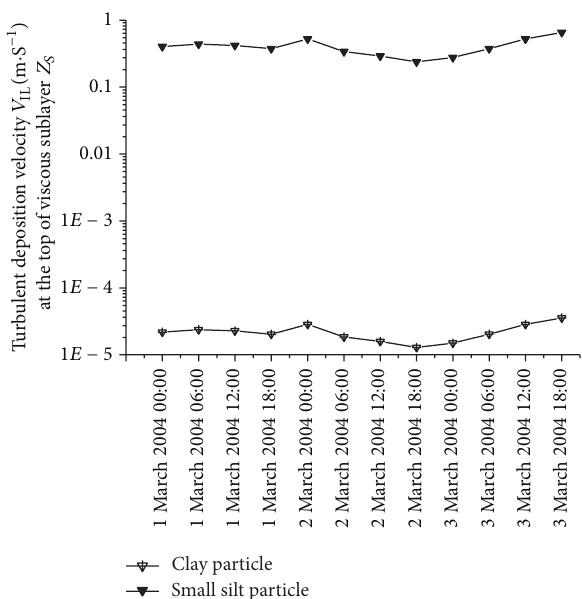
Figure 7: Evolution of dry deposition velocity of both particles clay and small silt over Gran Canaria from 1 to 3 March 2004.